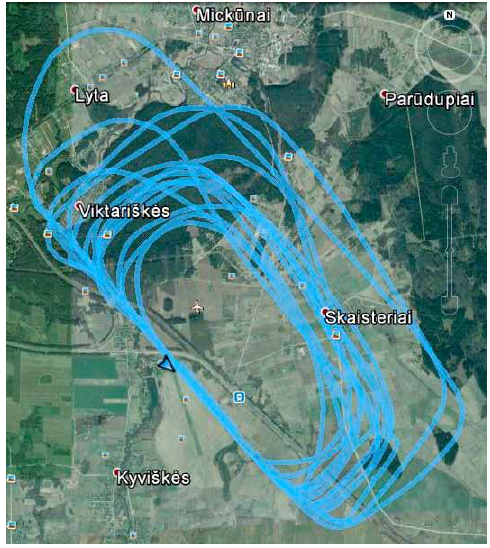
Fig. 2. Real flight circuit trajectories in Kyviškės aerodrome